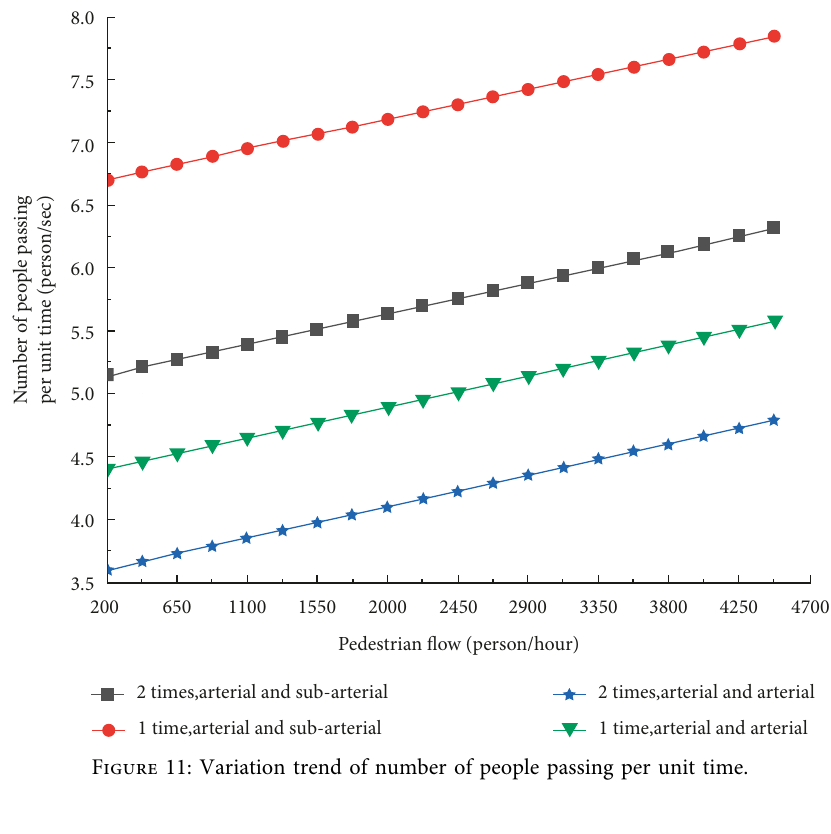
Figure 11: Variation trend of number of people passing per unit time.